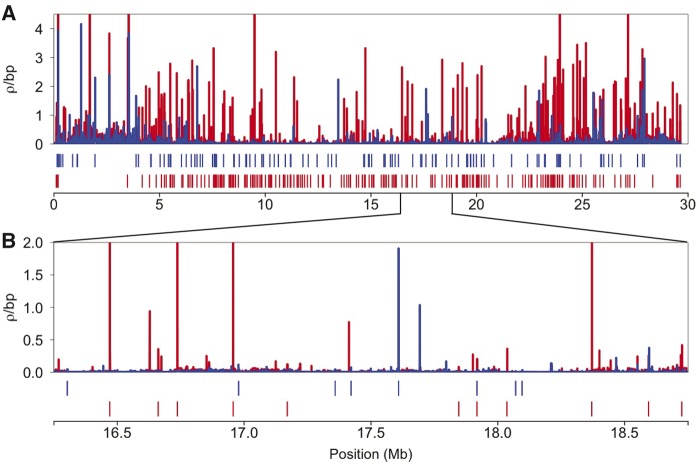
—Recombination rates vary at a fine-scale across chromosome one. (A) Population-scaled recombination rates across chromosome one are shown for Puget Sound (red) and Lake Washington (blue). (B) A subset of chromosome one is shown to highlight population-specific peaks of recombination across a narrow 2.5-Mb region. Only recombination rates below 4.5 ρ/bp are shown. Tick marks below each chromosome indicate the location where hotspots were identified. The remaining chromosome plots are in supplementary figures 6 and 7, Supplementary Material online.